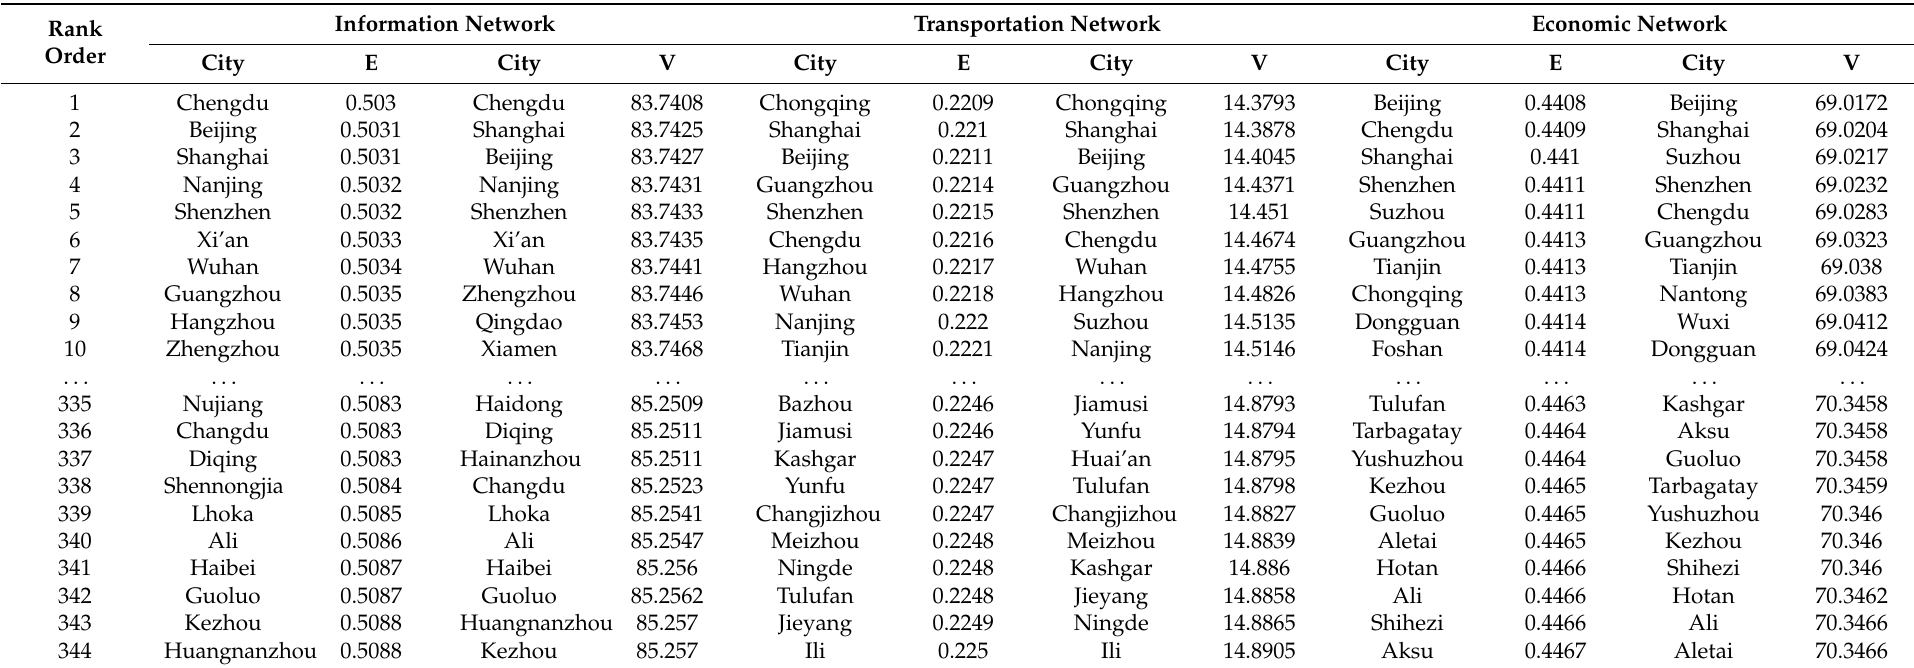
Table 1. Top ten and bottom ten cities affecting network transmissibility (E) and diversity